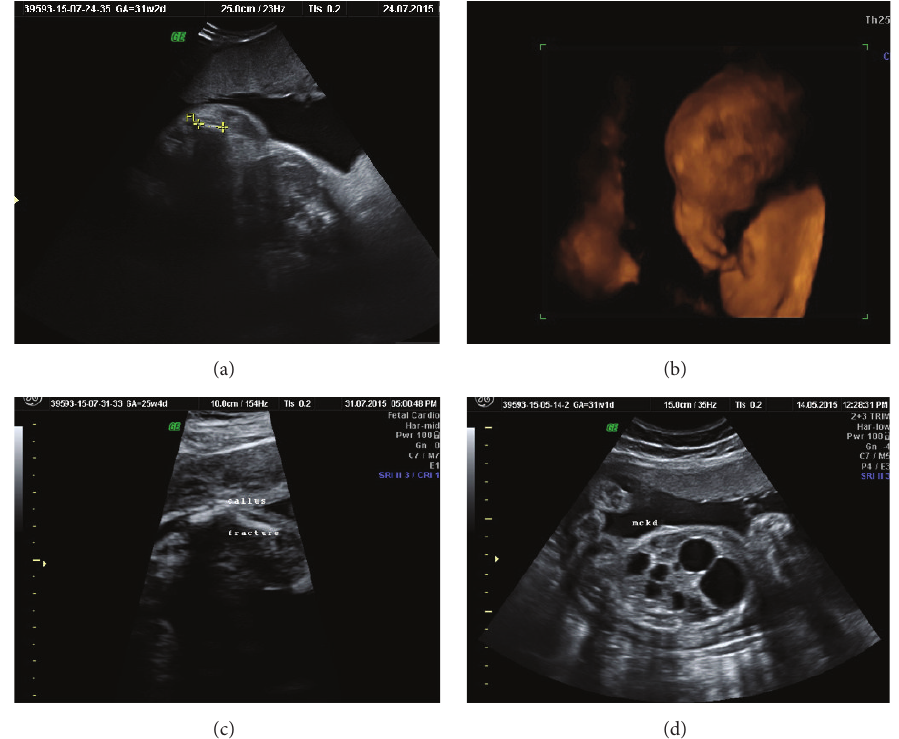
Figure 5: (a, b, and c) show skeletal malformation achondrogenesis (3D), thanatophoric dysplasia, and osteogenesis imperfecta. All of them potentially diagnosable before 12 weeks and usually before 20 weeks were missed and were diagnosed late. (d) shows bilateral multicystic dysplastic kidney diagnosed at 31 weeks, with fetus being continued as